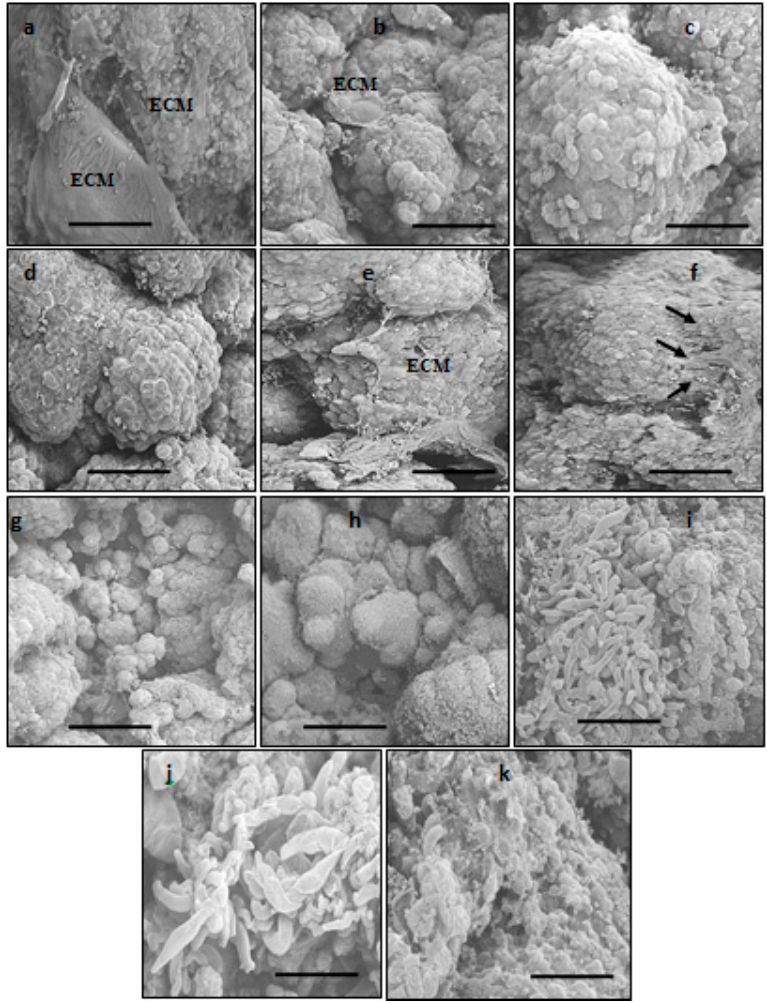
Figure 7. The electron micrograph of MR220 ( a , b , c , d , i ) and MR220-CL2 ( e , f , g , h , j , k ). ( a , b , e ): The embryogenic callus surface covered with thin membranous structure (indicated by extracellular matrix surface (ECM)); ( c , d ): Globular, compact structure covered the callus surface; f : Fibrillary structure (indicated by arrows) with packed cells; g : Globular, compact structure within callus cluster; ( h , i ): Enlargement detail of non-embryogenic callus surface with long tubular structure; j : Finger-like structure on non-embryogenic callus and k: Unorganized membranous layer on the non-embryogenic callus surface (Bar = 500 mm for a–g , i , j ; 200 mm for h , k ).